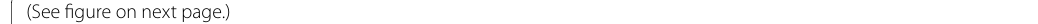
Fig. 1 Tubule-specific Pacs-2 deletion aggravates kidney injury in HFD/STZ treated mice. A and B Western blot and quantification of PACS-2 expression showing that PACS-2 was knocked out in renal cortex. C Body weight and D blood glucose are shown. E Kidney weight/body weight (KW/BW) ratio, F Urine albumin-to-creatinine ratio (UACR) and urinary NAG in mice are shown. G Morphological examinations of tubular and glomerular changes by HE, PAS, Masson staining. Scale bars: 50 μm. H and I Quantification of tubular damage score and glomerular damage score of the kidneys in each group. All data are presented as means SD; *p < 0.05, **p < 0.01, ***p < 0.001, ns, not significant. n ± =